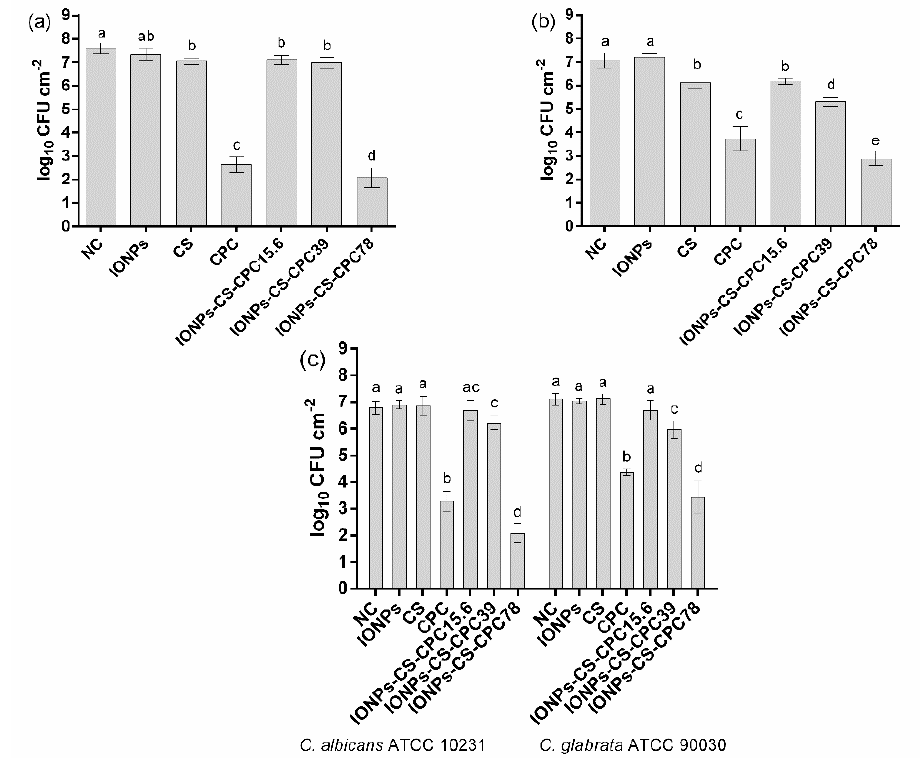
Figure 3. Quantification of biofilm cultivable cells. Mean values of the logarithm of colony-forming units per cm 2 for single biofilms of Candida albicans ATCC 10231 ( a ) Candida glabrata ATCC 90090 ( b ) and dual-species biofilms ( c ) treated with 54.6 µg mL − 1 iron oxide nanoparticles (IONPs), 54.6 µg mL − 1 chitosan (CS), 78 µg mL − 1 cetylpiridinium chloride (CPC) and nanocarrier containing CPC at 15.6 (IONPs-CS-CPC15.6), 39 (IONPs-CS-CPC39) and 78 µg mL − 1 (IONPs-CS-CPC78). Negative control (NC) indicates biofilms treated with pure artificial saliva (without drugs). Error bars represent standard deviations of the means. Different lower case letters indicate significant differences among the groups by one-way ANOVA and Fisher LSD’s test ( p < 0.05).